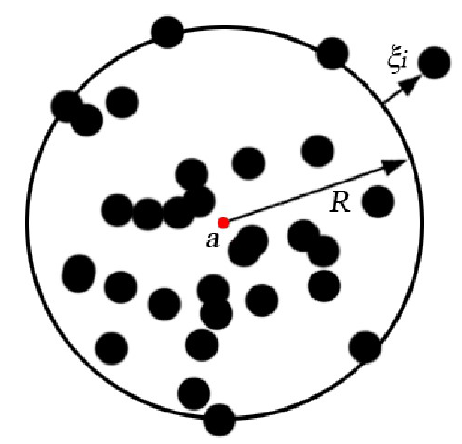
Figure 1. A support vector data description geometric